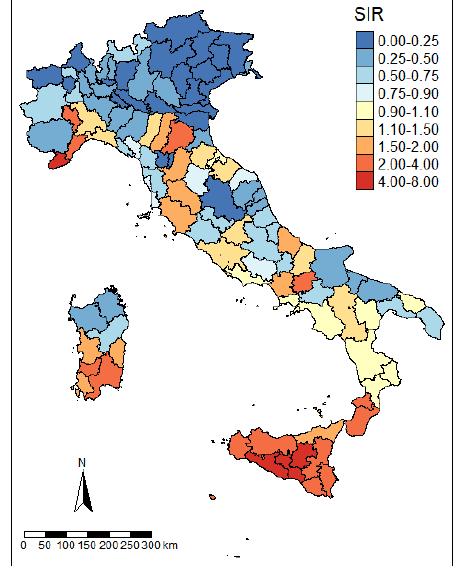
Figure 3. VL standardized incidence rates by Italian provinces (2009–2016) . Choropleth map repre- senting VL standardized incidence ratio (SIR) at province level for the 2009–2016 period. Provinces with higher risk than the Italian average (SIR > 1.10) are represented in shades of red, while provinces with lower risk (SIR < 0.90) are represented in shades of blue.